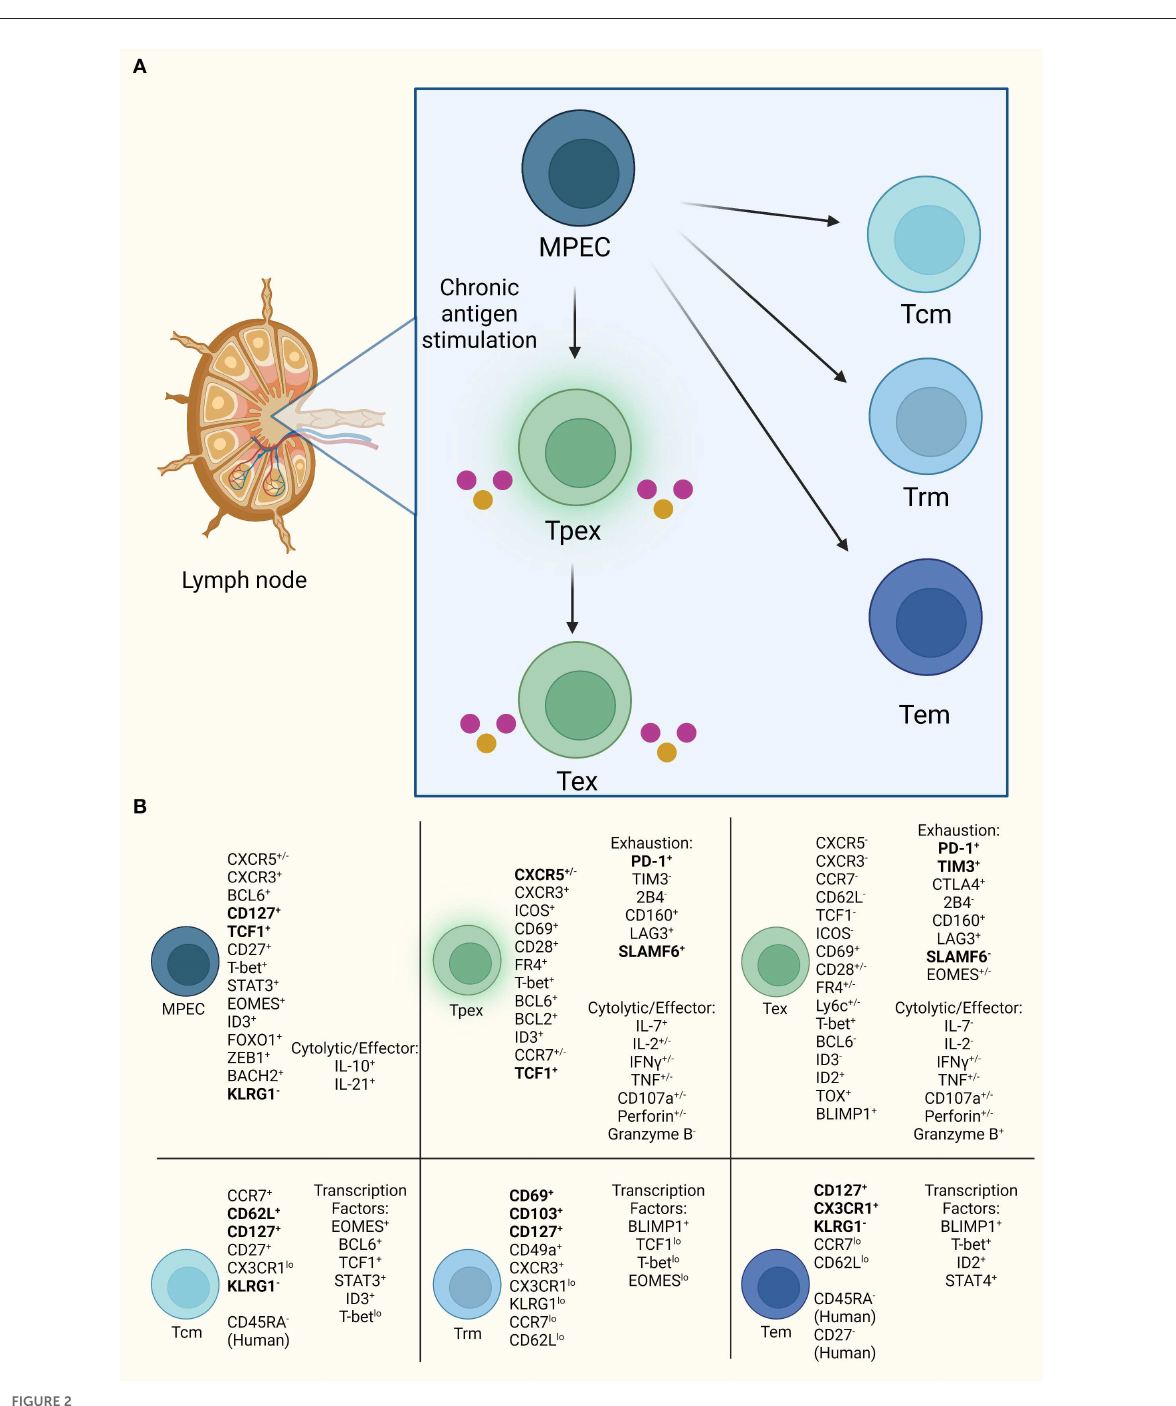
human liver and tumor tissue compared to blood circulation (29). PD-1, TIM3, 2B4, and Lag3 are downregulated in